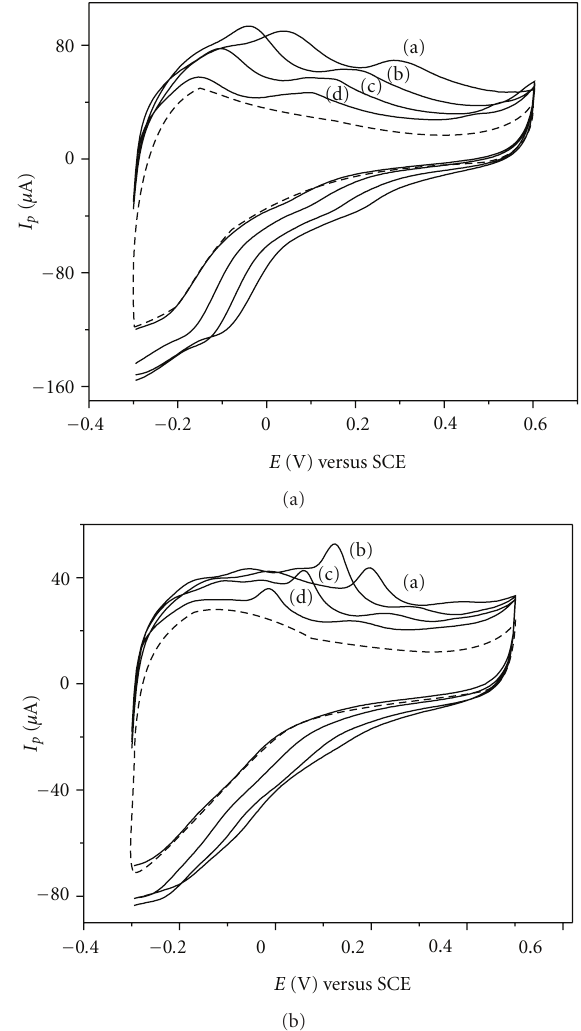
Figure 2: Cyclic voltammograms of (A) CD and (B) BS in 0.1 M PBS at pH (a) 5.0, (b) 6.0, (c) 7.0, and (d) 8.0 with MWCNTs/PNB- modified electrode. Dashed lines: 0.1 M PBS at pH 8.0. CD and BS concentrations: 100 µ M. Scan rate 50 mVs − 1